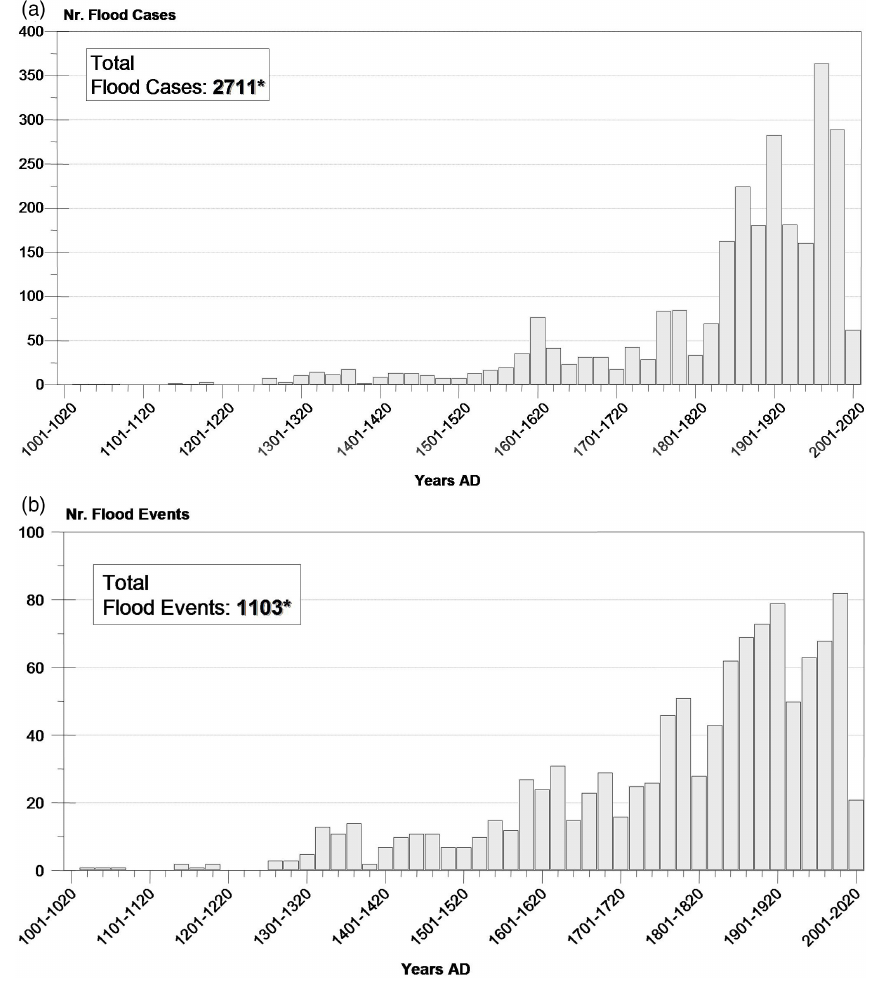
Figure 2. Bidecadal distribution of flood cases (a) and flood events (b) of the Prediflood database information (own elaboration). ∗ Three flood cases/events fall outside of the period